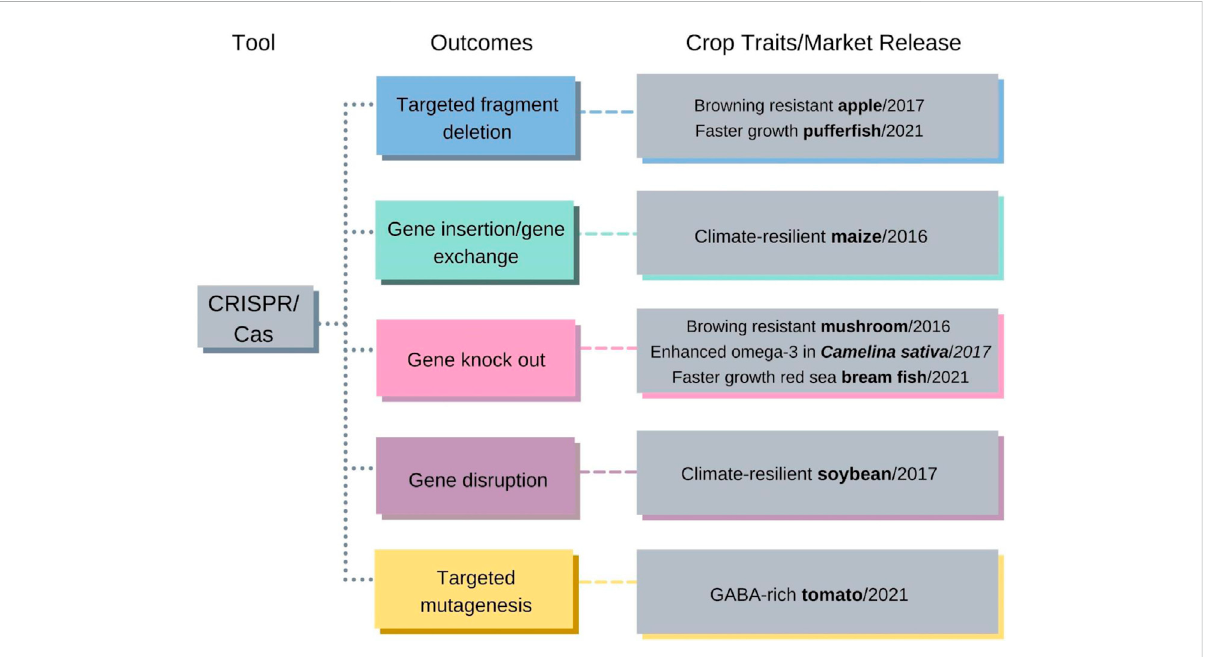
FIGURE 1 CRISPR/Cas and its outcomes and characteristics of crops already available on the market. Colored arrows and boxes link published crop trait examples and year of market release with the associated genome-editing tool and outcome (Jansing et al., 2019). Copyright 2019, MDPI, Basel,